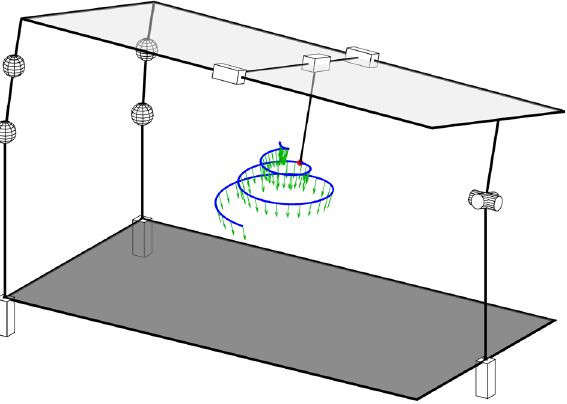
Figure 5. Spiral-helical trajectory for velocity analysis. Green arrows show end-effector orientation.